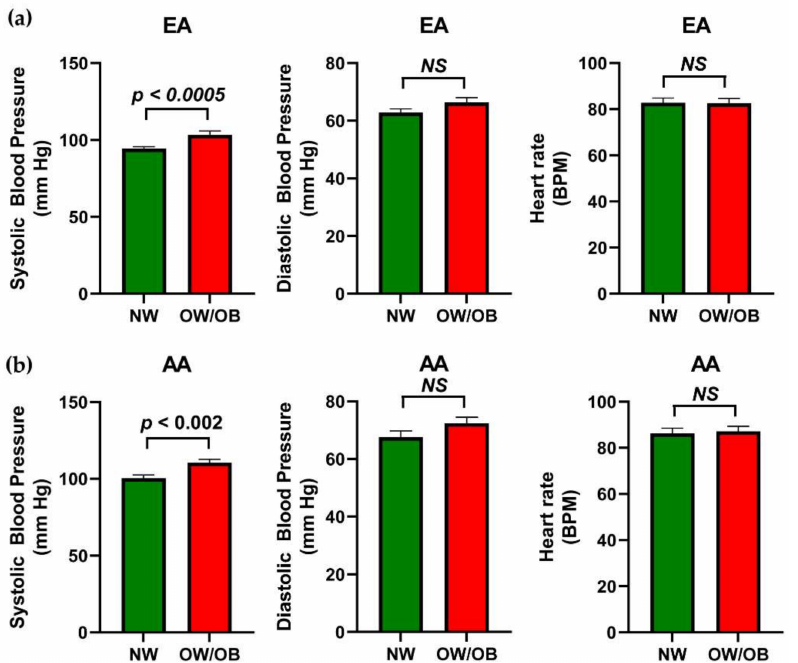
Figure 4. Comparison of blood pressure in NW and OW/OB children of EA and AA participants. The bar graphs shows the differences in the blood pressure in the NW and OW/OB groups of ( a ) EA participants and ( b ) AA participants. Values are expressed as mean ±